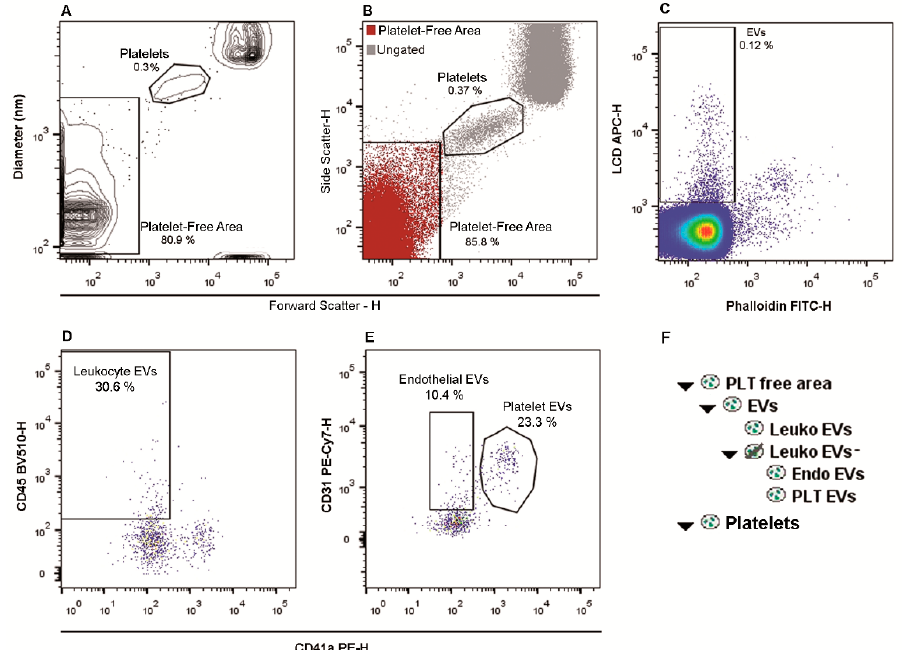
Figure 1. Gating Strategy for extracellular vesicles (EVs) identification and subtyping. ( A ). A platelet-free area region was defined on a Forward Scatter-H/Diameter dot-plot (.fcs files were transformed by the Rosetta system). ( B ). All events were also represented on a Forward Scatter-H/Side Scatter-H dot-plot and, by using platelets as a reference population, the same area free from platelets, evidenced in A, can be gated. ( C ). The “Platelet-free area” was shown on a Phalloidin- H/Lipophilic Cationic Dye (LCD)-H dot-plot and EVs were identified as LCD positive/phalloidin negative events. ( D ). EVs (LCD+/Phalloidin- events) were analyzed on a CD45-H/CD41a-H dot-plot and CD45+ events were identified as leukocyte- derived EVs (Leukocyte EVs). ( E ). A logical gate excluding all the CD45+ events was then obtained, and the resulting population was plotted on a CD31-H/CD41a-H dot-plot. Events showing the CD31+/CD41a+ phenotype were identified as platelet-derived EVs (Platelet EVs), whereas the CD31+/CD41a- compartment represented endothelium-derived EVs (Endothelial EVs). The percentages reported in the dot-plots were calculated based on the gating hierarchy that we have used. ( F ). The applied gating hierarchy is shown as a